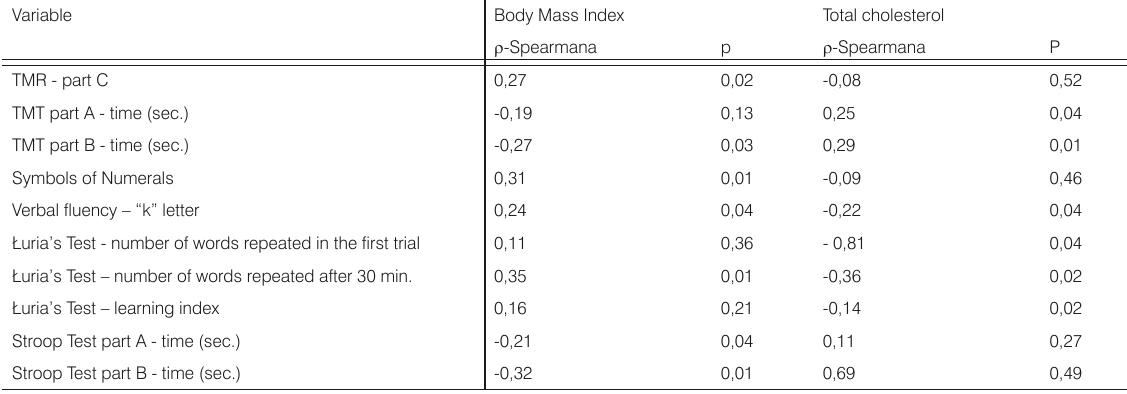
Table 1. The ρ -Spearman’s correlation coefficient for value of Body Mass Index, total cholesterol concentration and cognitive functions.